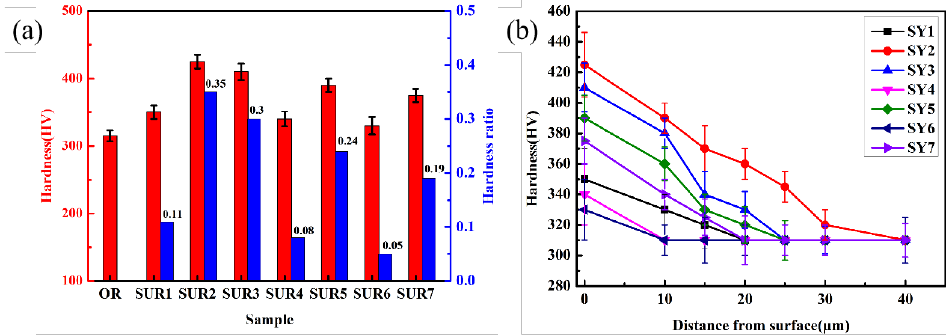
Figure 7. Hardness changes under different surface ultrasonic rolling processes. ( a ) Surface hardness change, ( b ) cross-sectional hardness change.